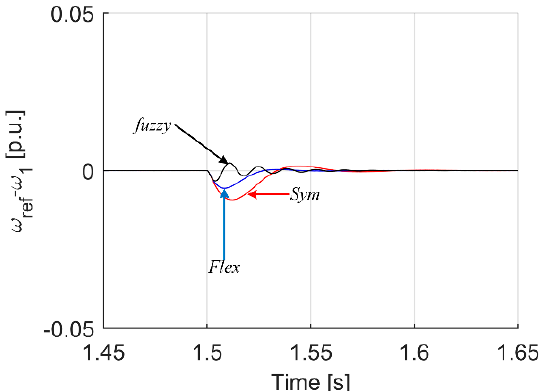
Figure 9. Transients of difference between motor, load and reference speed under torque load change.